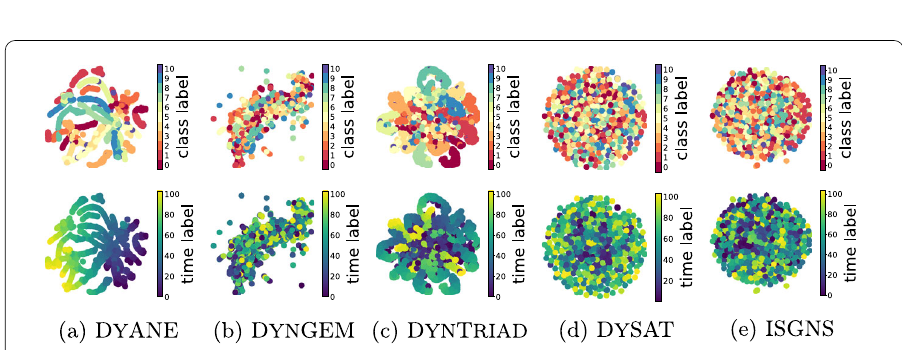
Figure 4 Two-dimensional projections of the 128-dim embedding manifold spanned by dynamic node embeddings, trained on L YON S CHOOL data and obtained with Hadamard products { w i ◦ t k } rows of W (node embeddings) and T (time embeddings), from HOSGNS model trained on: ( a ) P (stat) and ( b ) P (dyn) . We highlight the temporal participation to communities (left of each panel) and the time interval of activation (right of each panel)